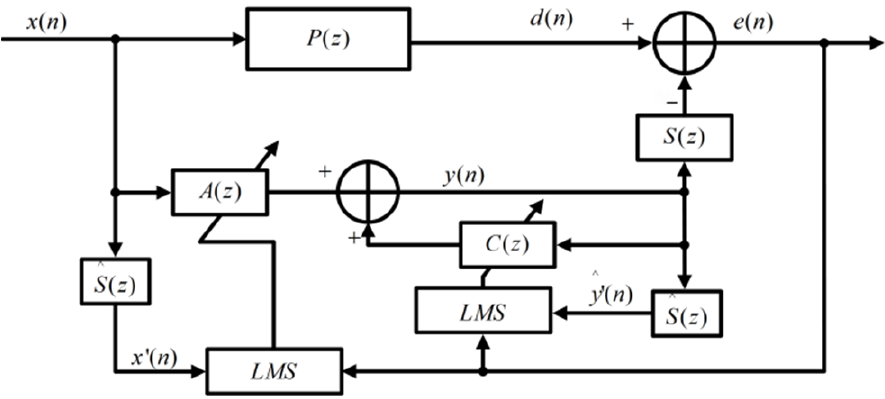
Figure 1. The output-error (OE)-model-based active noise control (ANC) system using the FURLMS algorithm.